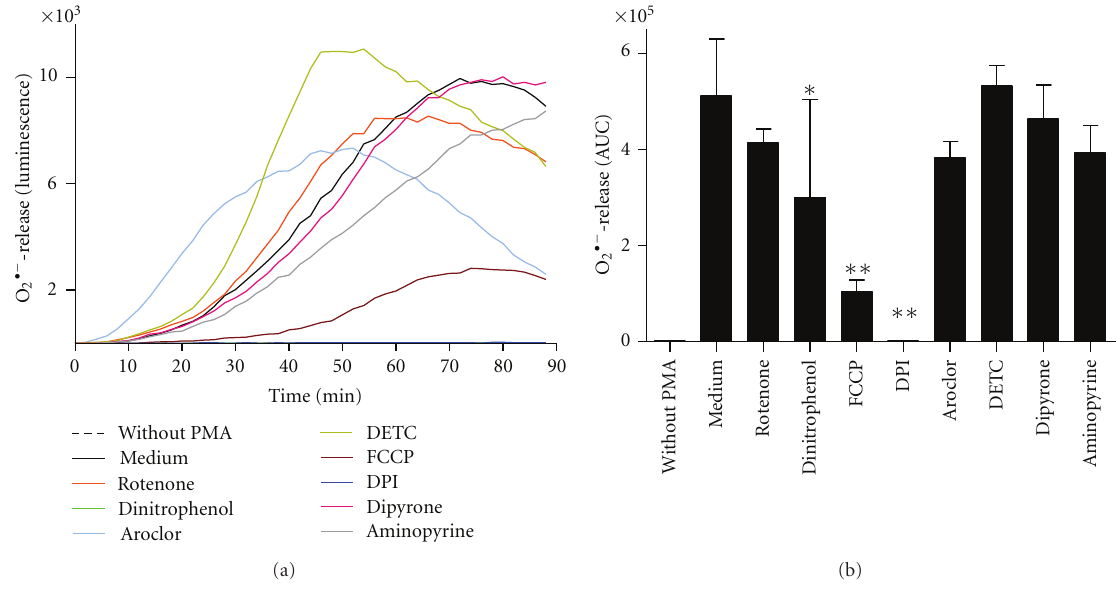
Figure 4: Extracellular ROS production of neutrophils incubated with various inhibitors as measured by the lucigenin-amplified chemiluminescence assay. Freshly isolated human neutrophils were incubated with or without inhibitors (10 µ M Rotenone, 10 µ M Dinitrophenol, 500nM FCCP, 20 µ M DPI, 38 µ M Aroclor, 10 µ M DETC, 200 µ M Dipyrone, and 200 µ M Aminopyrine) for 30min at 37 ◦ C. Subsequently, lucigenin was added, and the ROS production was induced with 20 nM PMA. The O 2 •− -release was detected by measuring chemiluminescence for a period of 1h at 37 ◦ C. The control without PMA shows the O 2 •− -release of unstimulated neutrophils. (a) Time kinetics of O 2 •− -release (chemiluminescence) in one representative experiment. (b) O 2 •− -release quantified by calculation of the area under the curve (AUC). Data show mean ± SD from four independent experiments, ∗∗ : P < 0 . 001; ∗ : P < 0 . 01 as compared to the PMA-stimulated sample without inhibitor